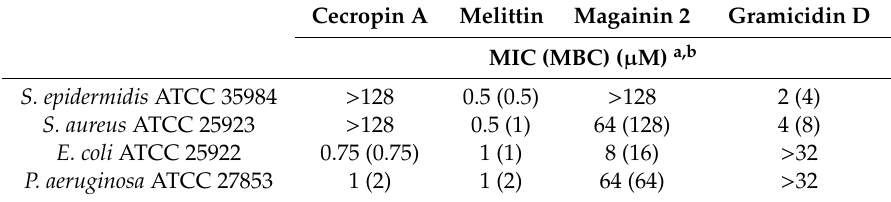
Table 1. Antimicrobial activities of selected antimicrobial peptides (AMPs) against reference strains.